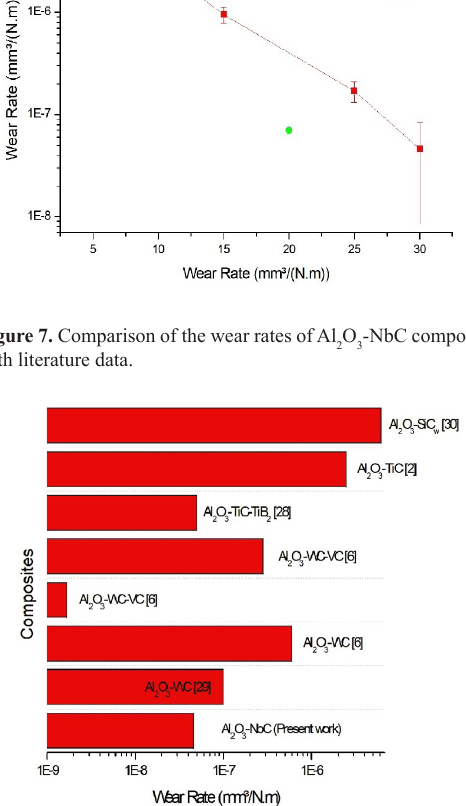
Figure 8. Wear rate of Al other reinforcements used in ceramic cutting